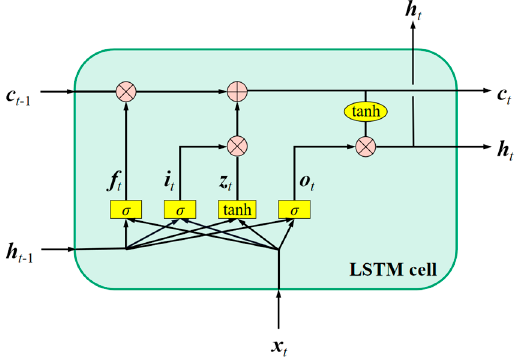
Figure 2. Basic architecture of LSTM unit. h t and c t denote short-term state and long-term state, respectively. f t , i t and o t represent forgetting gate, inputting gate and outputting gate, respectively, which controls the path of information transmission. z t is the candidate state obtained by the nonlinear function, σ is Logistic function, tanh is hyperbolic tangent function. ⊗ and ⊕ denote the multiplication and addition of the corresponding elements, respectively. The detailed information for the LSTM unit can be referred to Ref. [44].